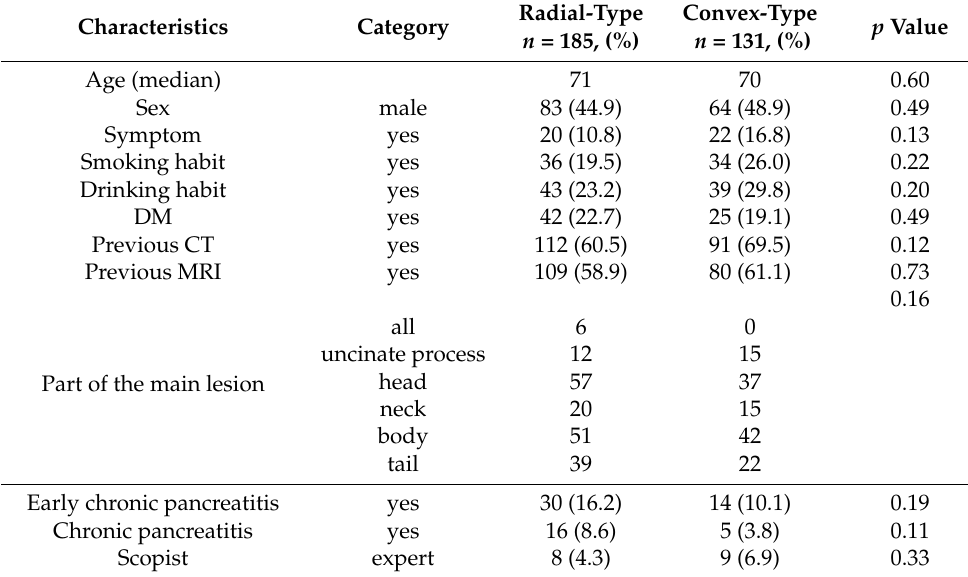
Table 1. The clinical characteristics of the patients.